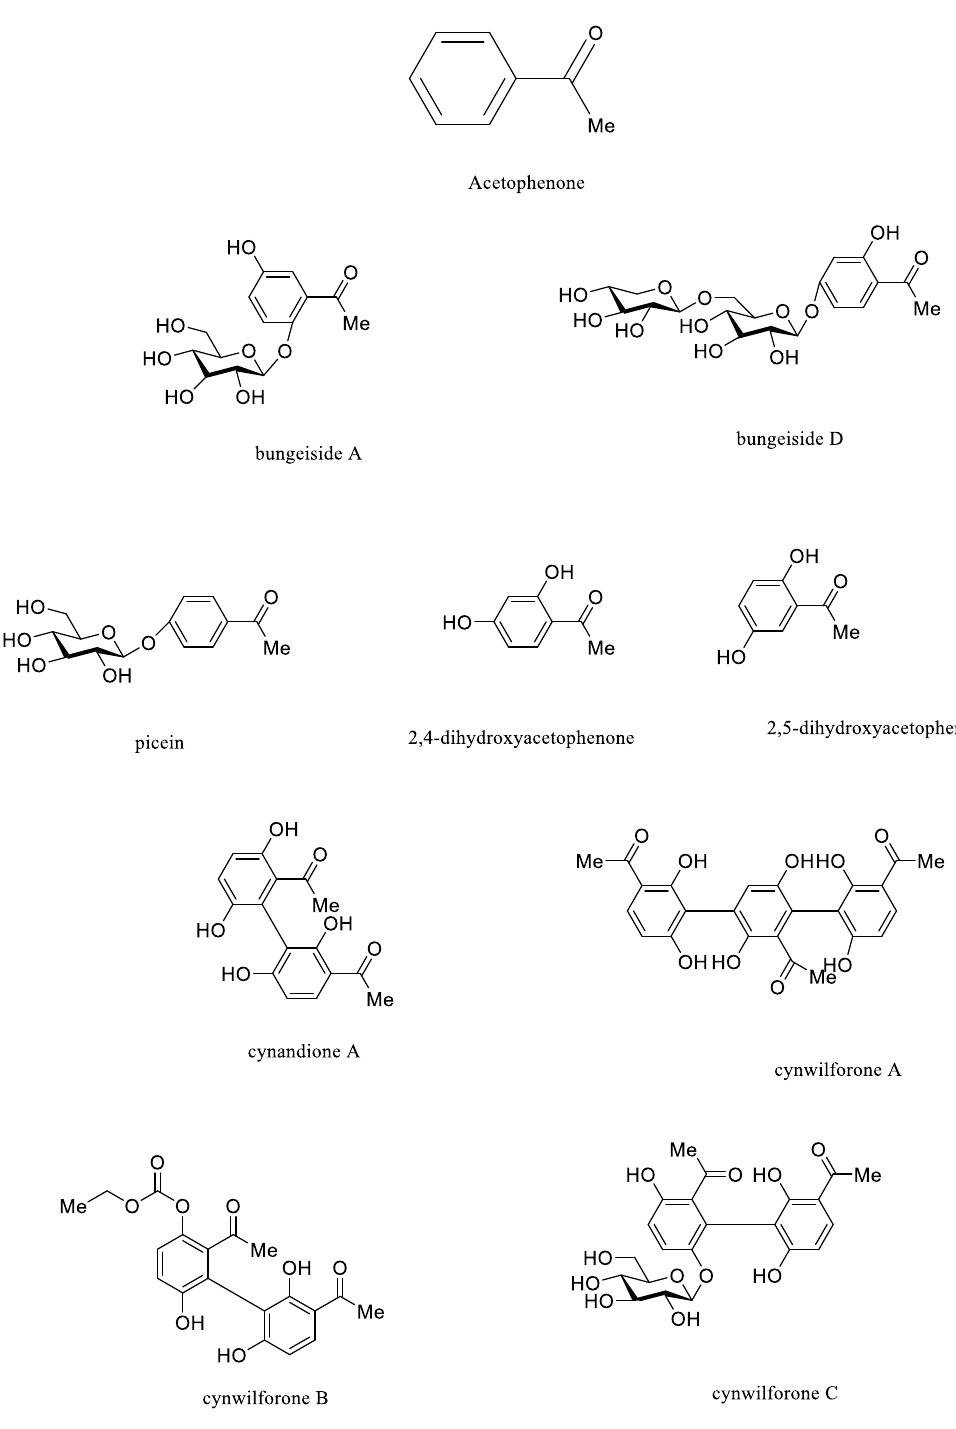
Figure 4. Representative structures of acetophenone compounds isolated from CA , CB and CW.